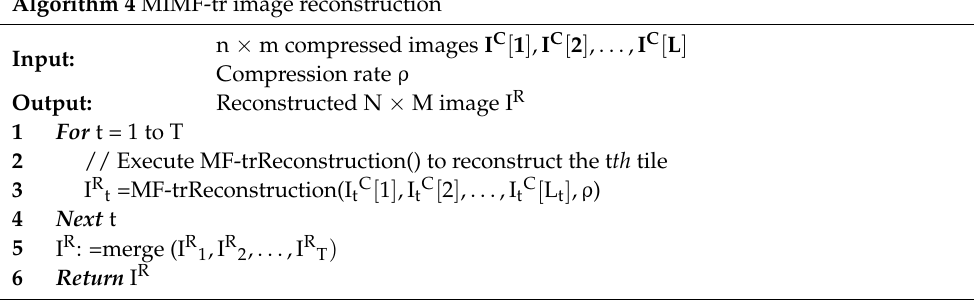
tr image reconstruction algorithm (Algorithm 4). Algorithm 4 MIMF-tr image